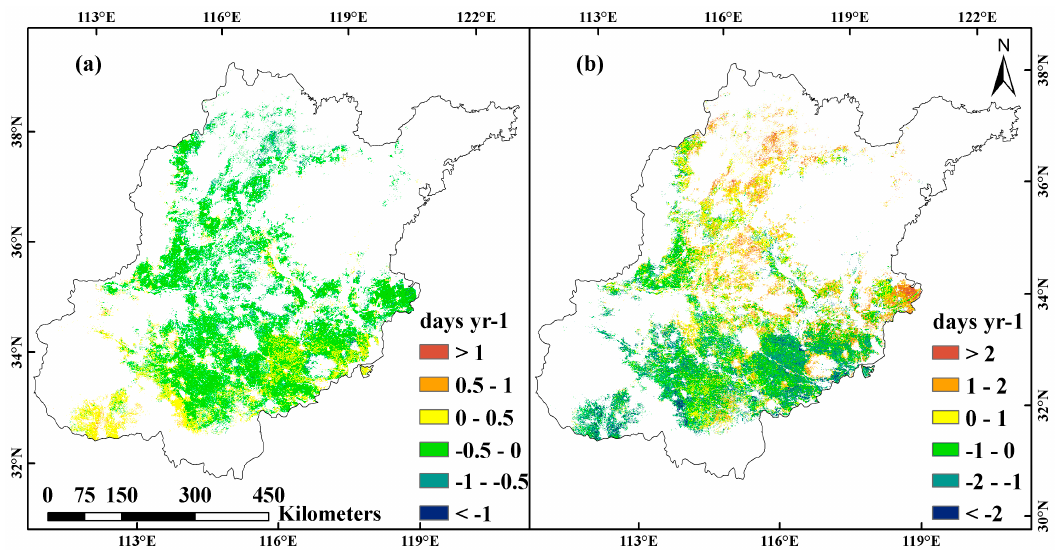
Figure 9. The changes in the LRGP induced only by climate warming ( a ) and non-climate e ff ects ( b ) during harvest years 2003–2018 across the